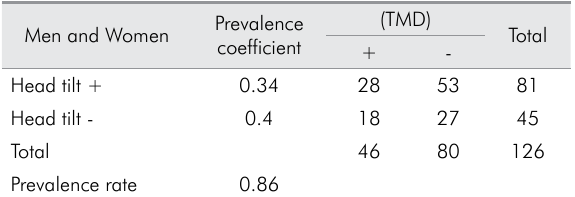
Table 4. Distribution of the number of men and women with (+) or without (-) TMD and head tilt.